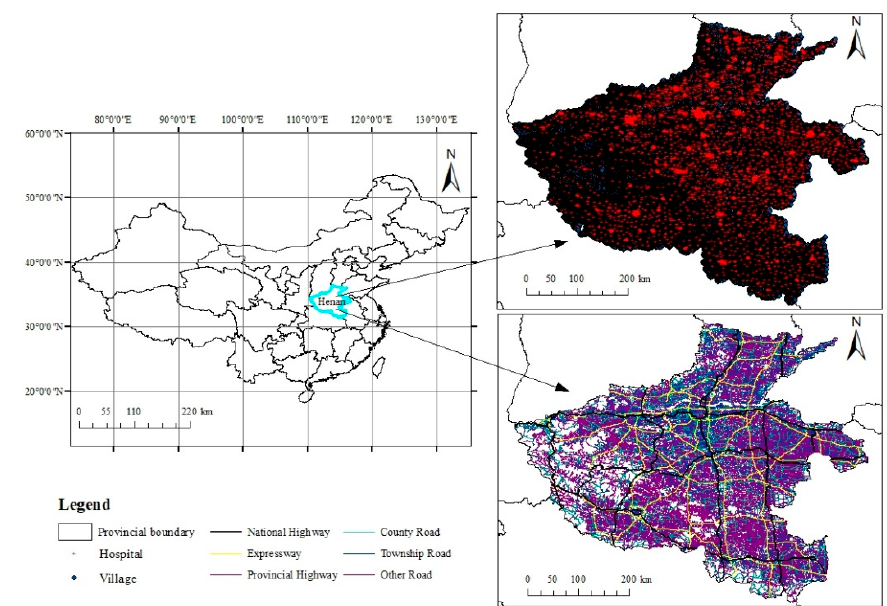
Figure 1. Road network and spatial distribution of villages and hospitals in the study area (Henan Province).